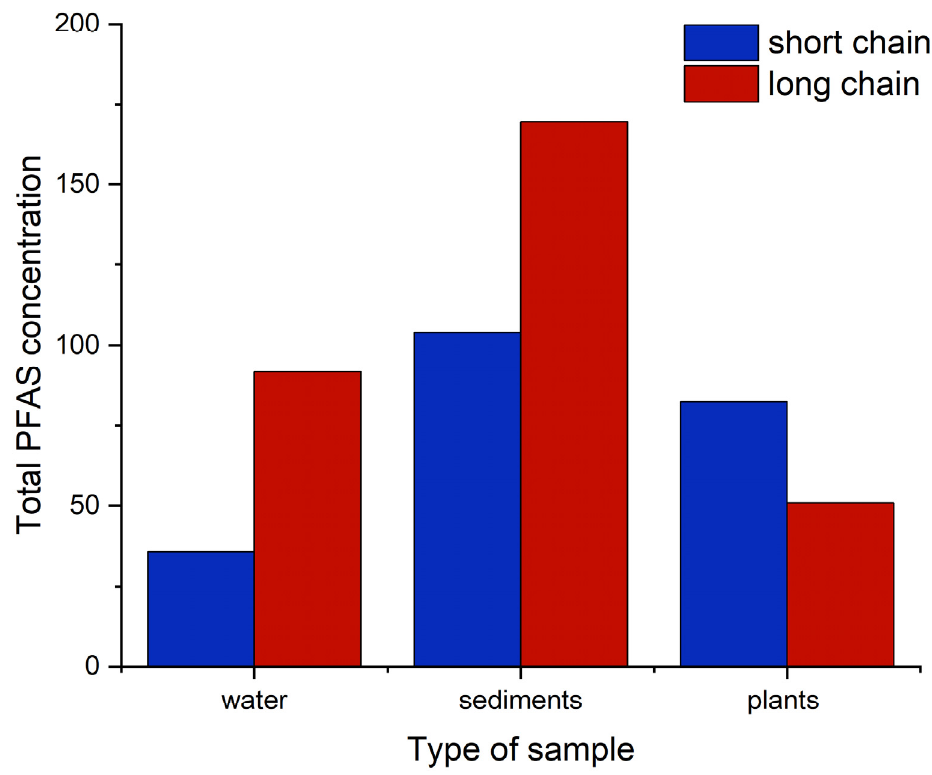
Figure 6. Classification of PFAS according to chain length in water, sediments, and plants. Concen- trations are in ng g − 1 for sediments and plants and ng L − 1 for water.